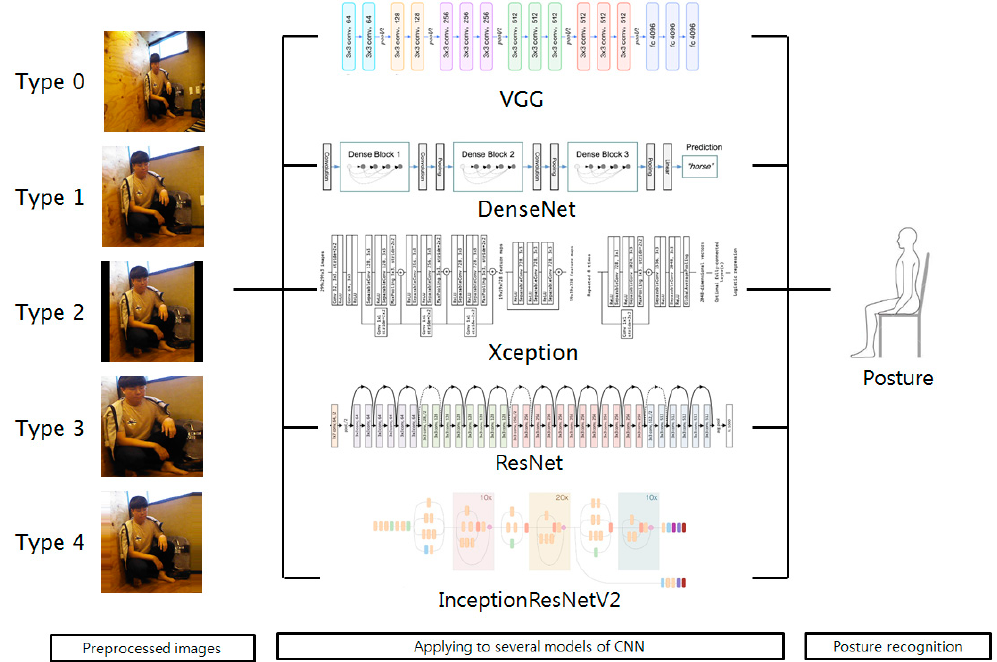
Figure 12. Ensemble deep models using the preprocessed images with different convolutional neural network (CNN) models. Appl. Sci. 2020 , 10 , x FOR PEER REVIEW